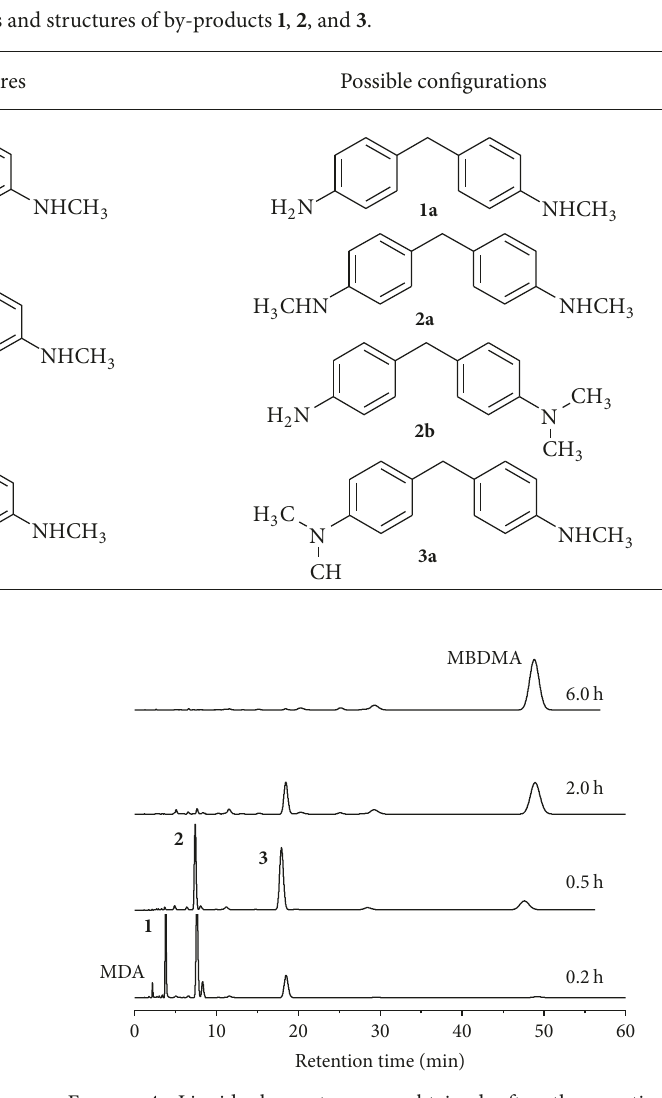
Figure 4: Liquid chromatograms obtained after the reaction between MDA and DMC under different reaction times.